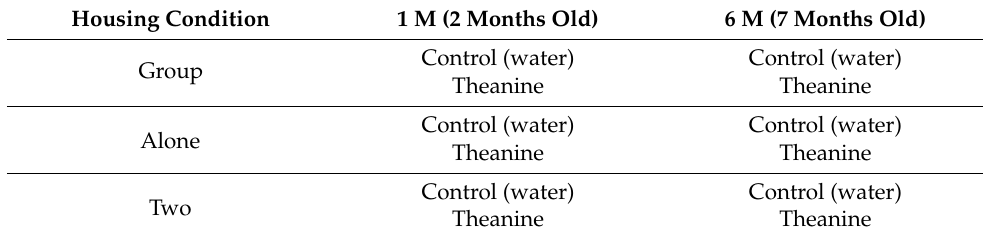
Table 3. Experimental